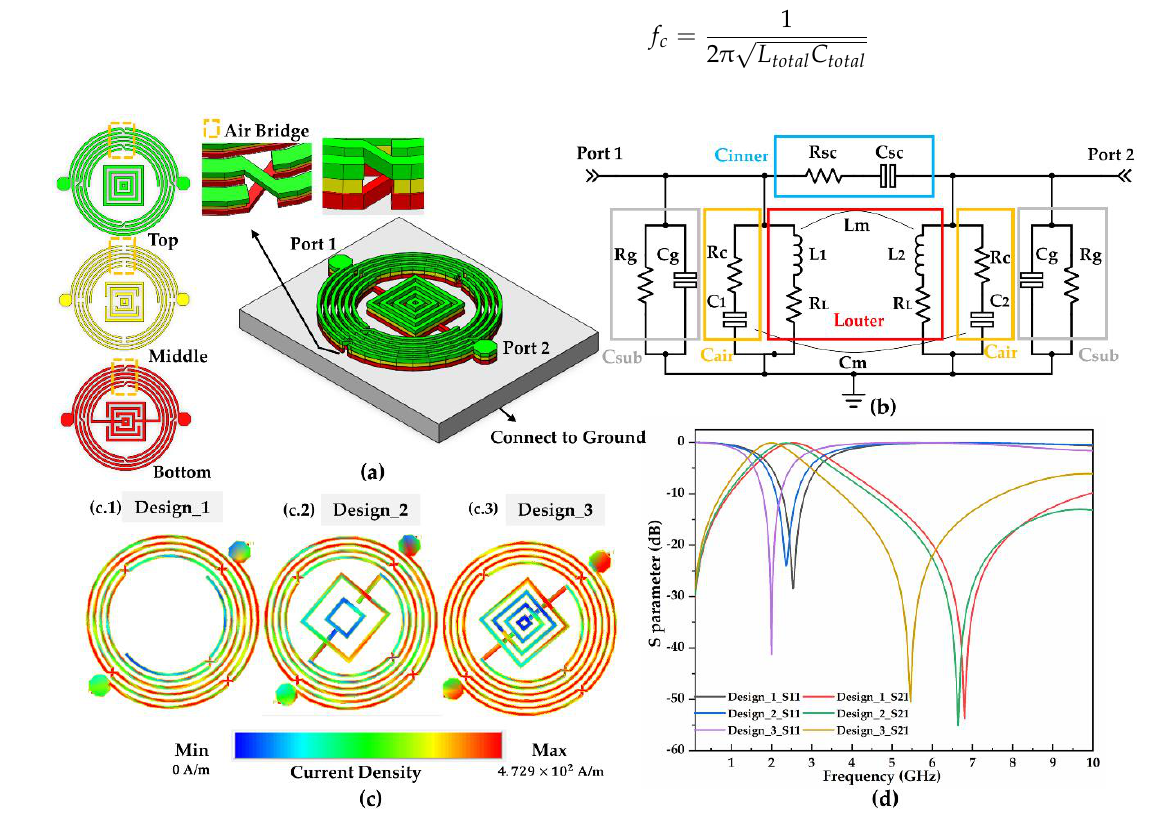
Figure 1. The conception of the proposed resonator-based biosensor: ( a ) The layout of the proposed biosensor with the three-layered structure; ( b ) The equivalent circuit of the proposed biosensor; ( c ) Various internal designs with current distribution conditions at the resonant frequency:(c.1) Current density distribution of Design.1; (c.2) Current density distribution of Design.2; (c.3) Current density distribution of Design.3; ( d ) Simulated S-parameters of the designs.